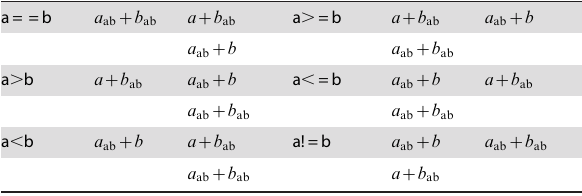
Operation Creation Destruction